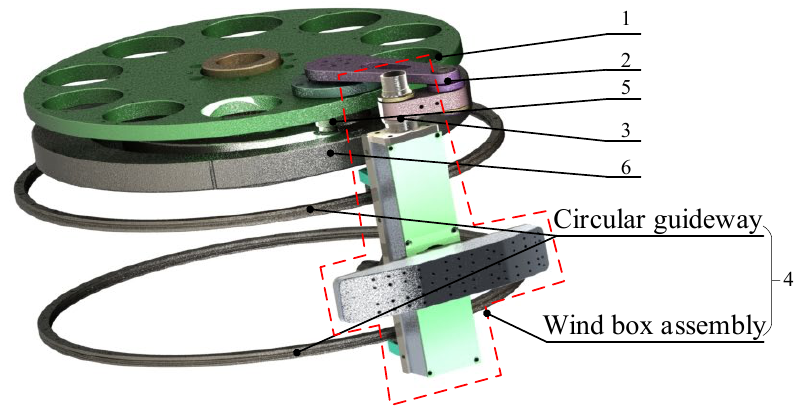
Figure 10 . Cam five-bar mechanism in the transverse device.